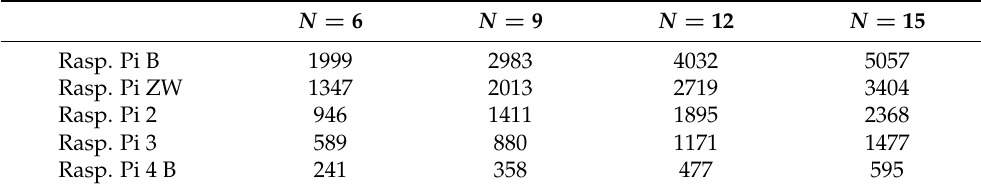
Table 8. Average execution time (in milliseconds) of the Grid Search (0.1 interval).